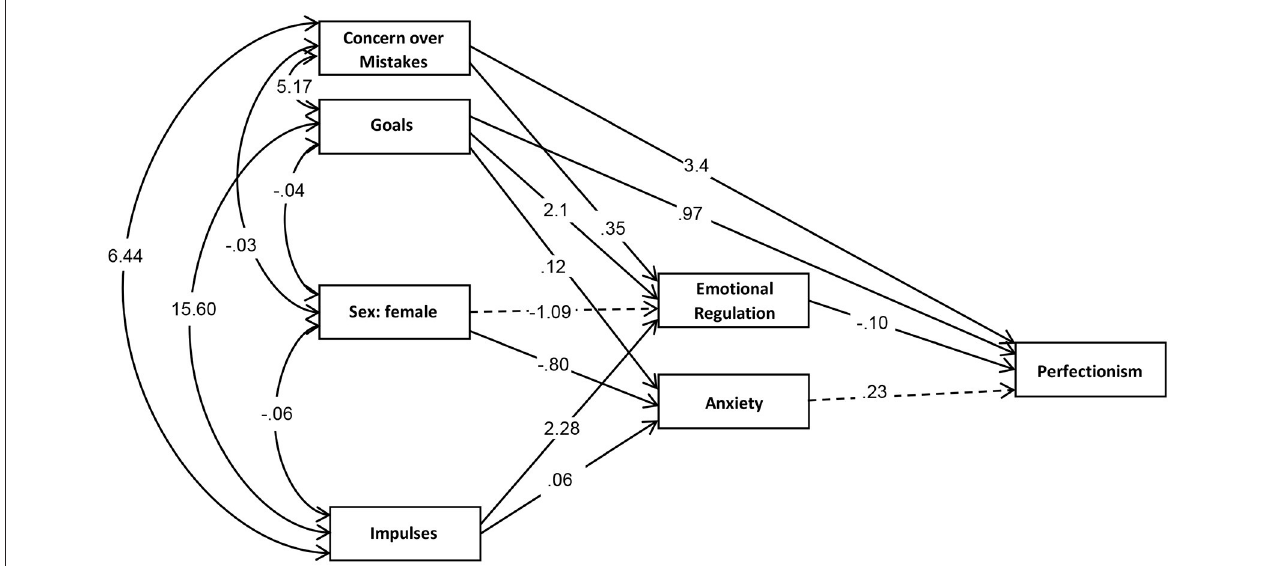
FIGURE 1 | Path diagram obtained in the SEM for perfectionism in patients with OCT, AN, and BN (standardized coefficients). OCD, Obsessive-Compulsive Disorder; AN, Anorexia nervosa; BN, Bulimia